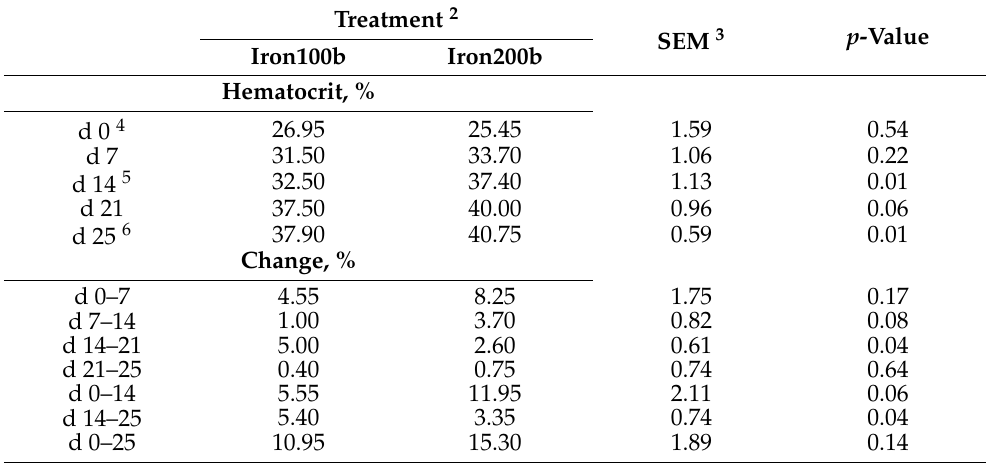
Table 4. Hematocrit level of pigs injected with different levels of iron at birth and additional iron before weaning in Experiment 2 1